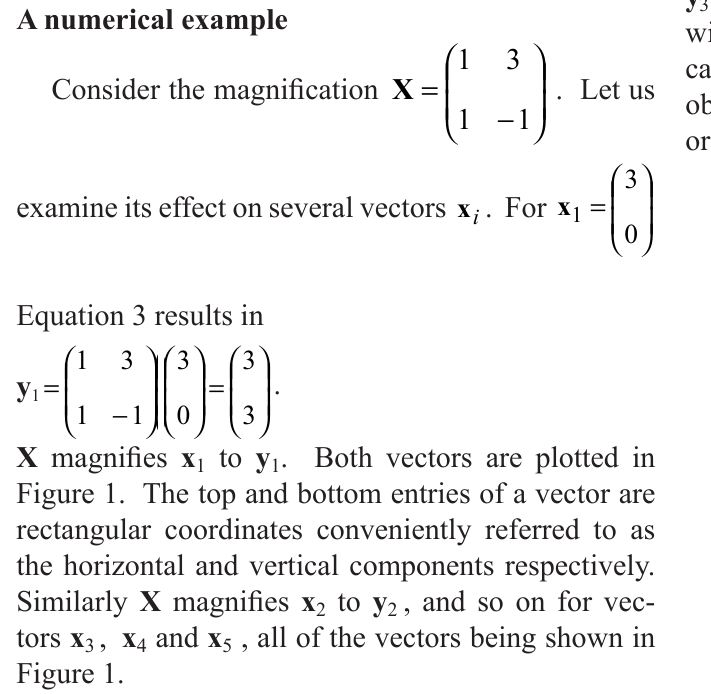
31    −= X on several 11 1 , x to y , x to y and so on. Magnification 1 2 1 3 3 2 is doubled in length 4 and x are eigenvectors of X and 2 4